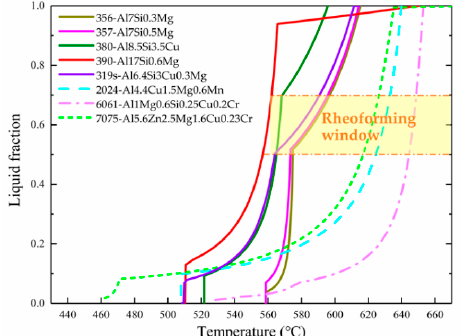
Table 1. Rheoforming windows and solidification ranges for the 7075 and 319s